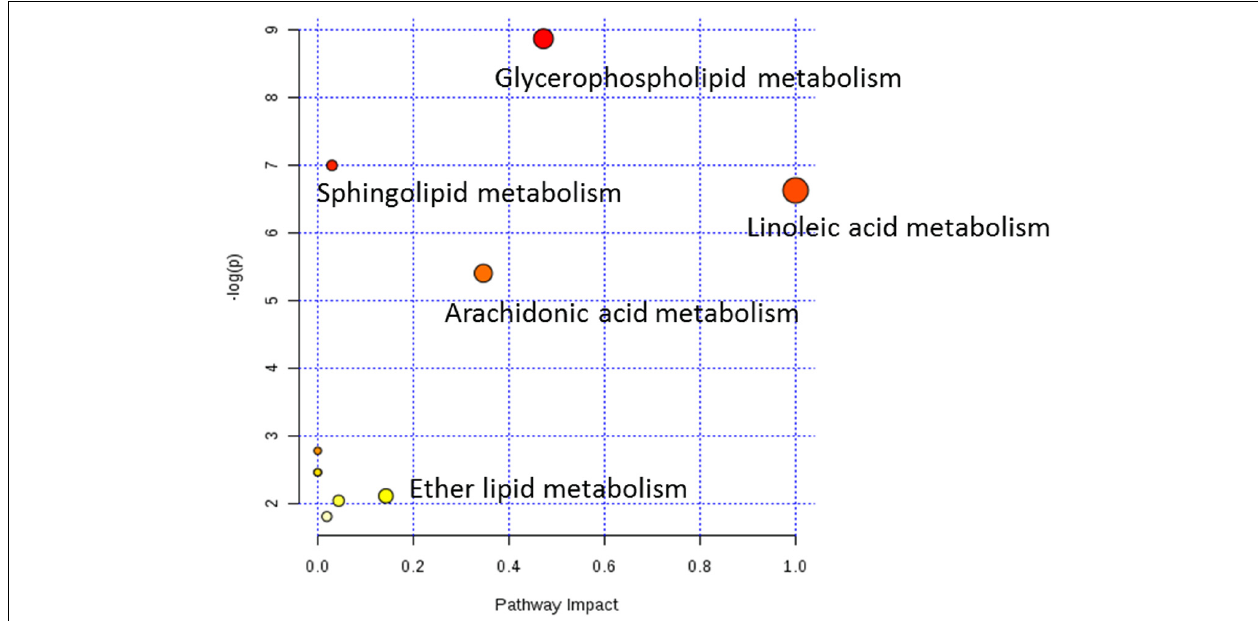
FIGURE 8 | Weighted analysis of the metabolic pathways based on the potential biomarkers